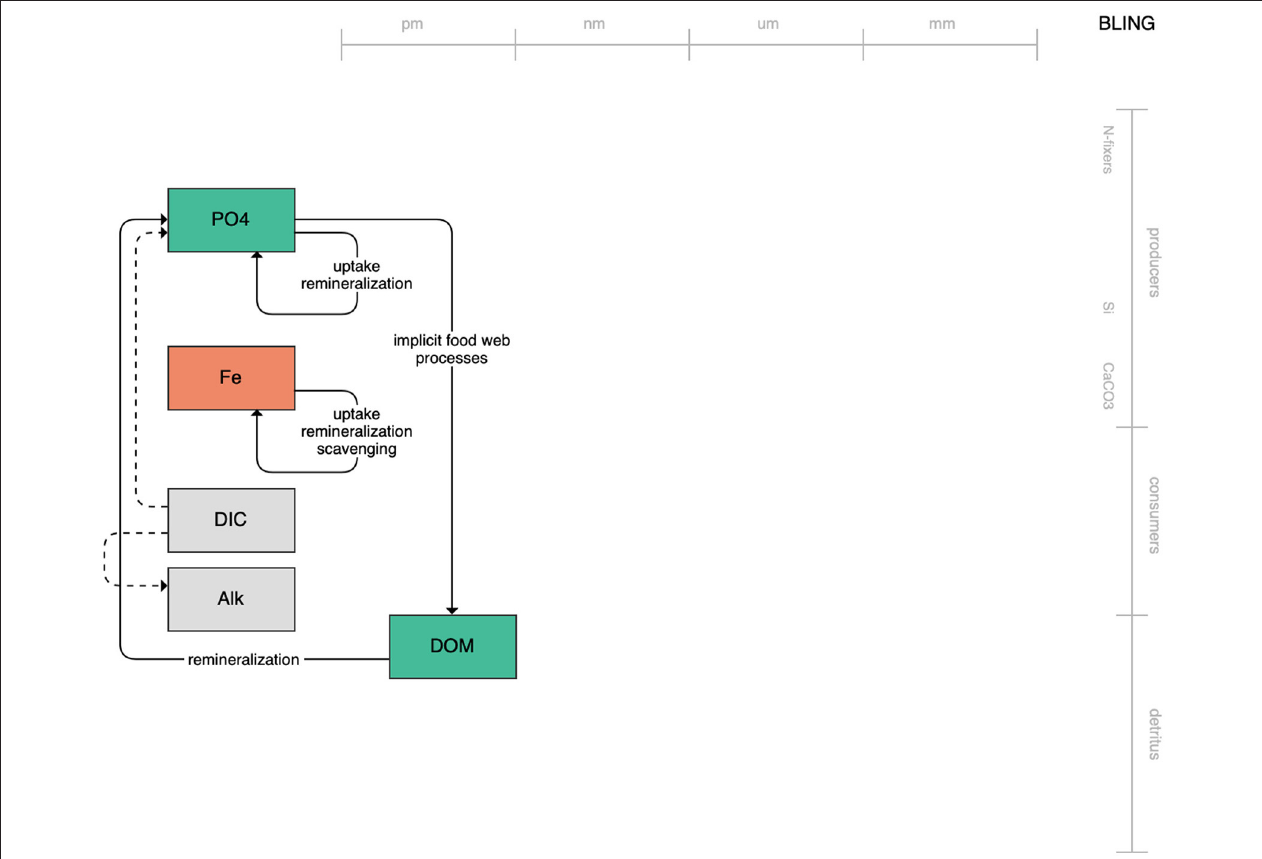
FIGURE 1 | Schematic for the BLING model. Figures 1 – 12 . Schematics for the CMIP6 ESMs. Boxes indicate state variables, and solid arrows represent fluxes between state variables; dashed lines indicate that the rate of change of one state variable is calculated proportionately to another. Colors indicate the base element for each state variable, with blue, green, pink, orange, and gray representing nitrogen, phosphorous, silicon, iron, and carbon, respectively. State variable boxes are positioned vertically based on functional role, indicating whether the functional group includes producers (and within that, subcategories of nitrogen fixers, Si-users, and CaCO3-users), consumers, or detritus. Horizontal position indicates the approximate mean size of the cells/bodies/particles represented by each state